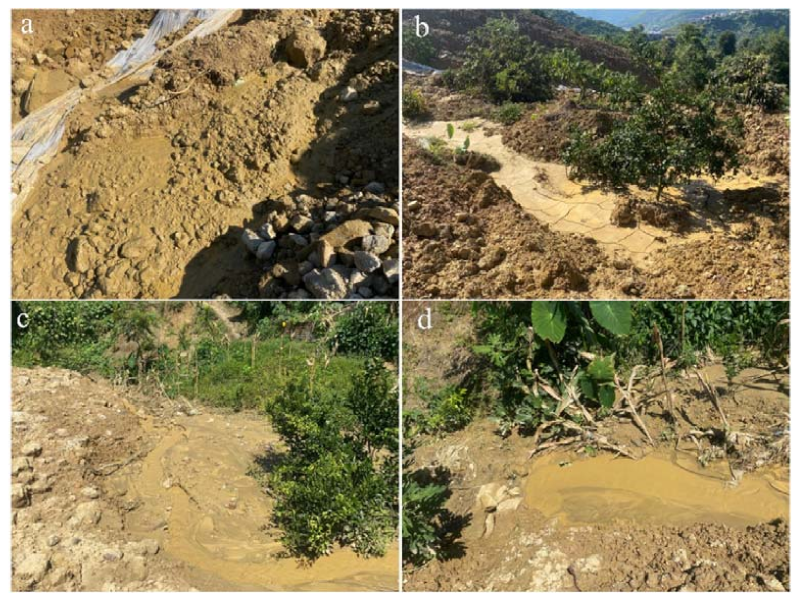
Figure 8. Fluidization phenomenon in the ( a ) rear, ( b , c ) middle and ( d )front of landslide area.